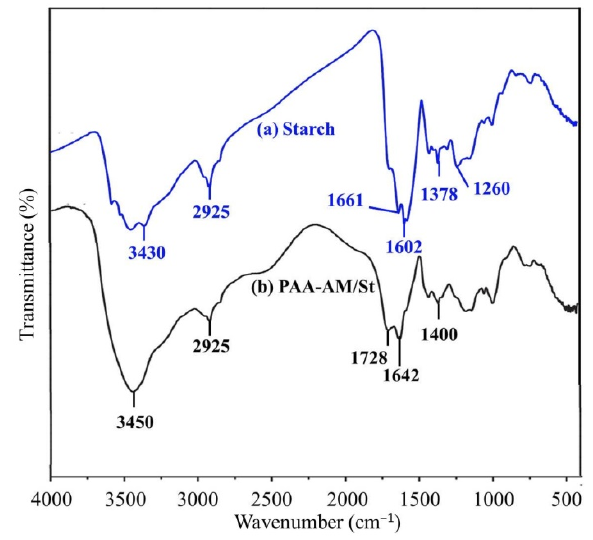
Figure 3. FT-IR spectra of ( a ) starch and ( b ) PAA-AM/St composite.